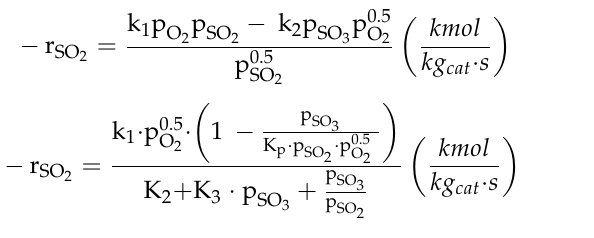
Table 1. Expressions of kinetic parameters and their temperature range of validity. Parameters Rate Constant